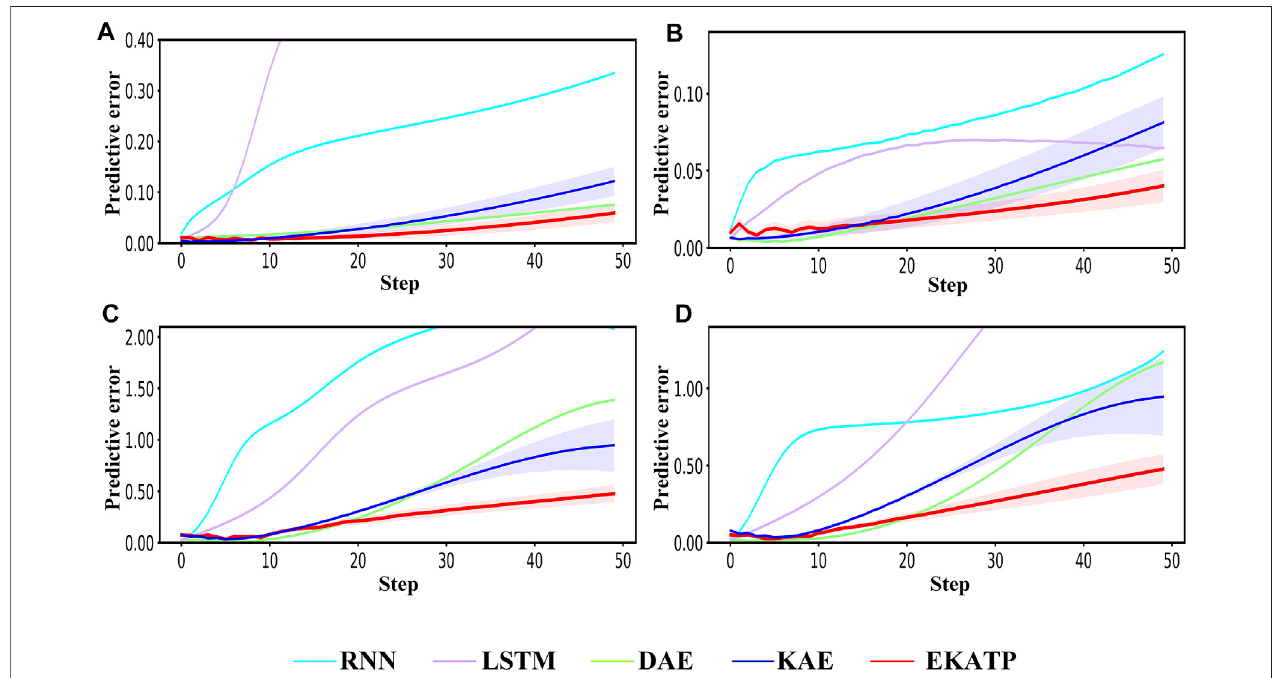
FIGURE 2 | Comparison among the RNN, LSTM, DAE, KAE and EKATP. The abscissa represents the step, and the ordinate represents the predictive error. (A) The initial conditions are h (cid:1) 0.003 and σ (cid:1) 0.00. (B) The initial conditions are h (cid:1) 0.003 and σ (cid:1) 0.01. (C) The initial conditions are h (cid:1) 0.006 and σ (cid:1) 0.00. (D) The initial conditions are h (cid:1) 0.006 and σ (cid:1) 0.01.